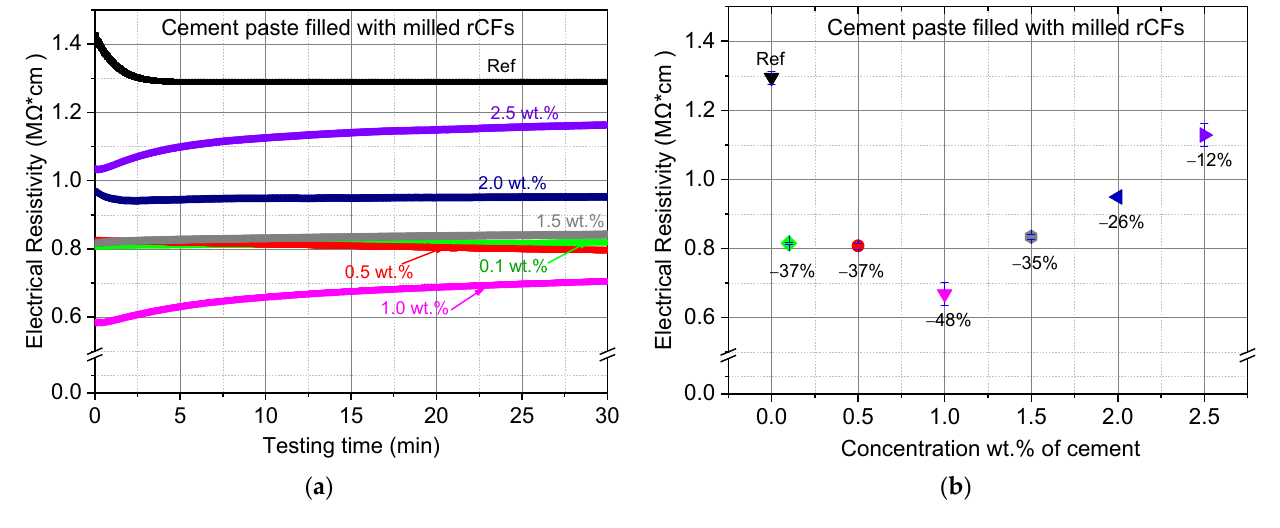
Figure 13. ( a ) Typical electrical resistivity over testing time curves of the investigated rCFs–cement composites; ( b ) Average electrical resistivity results of the GNPs–cement composites.